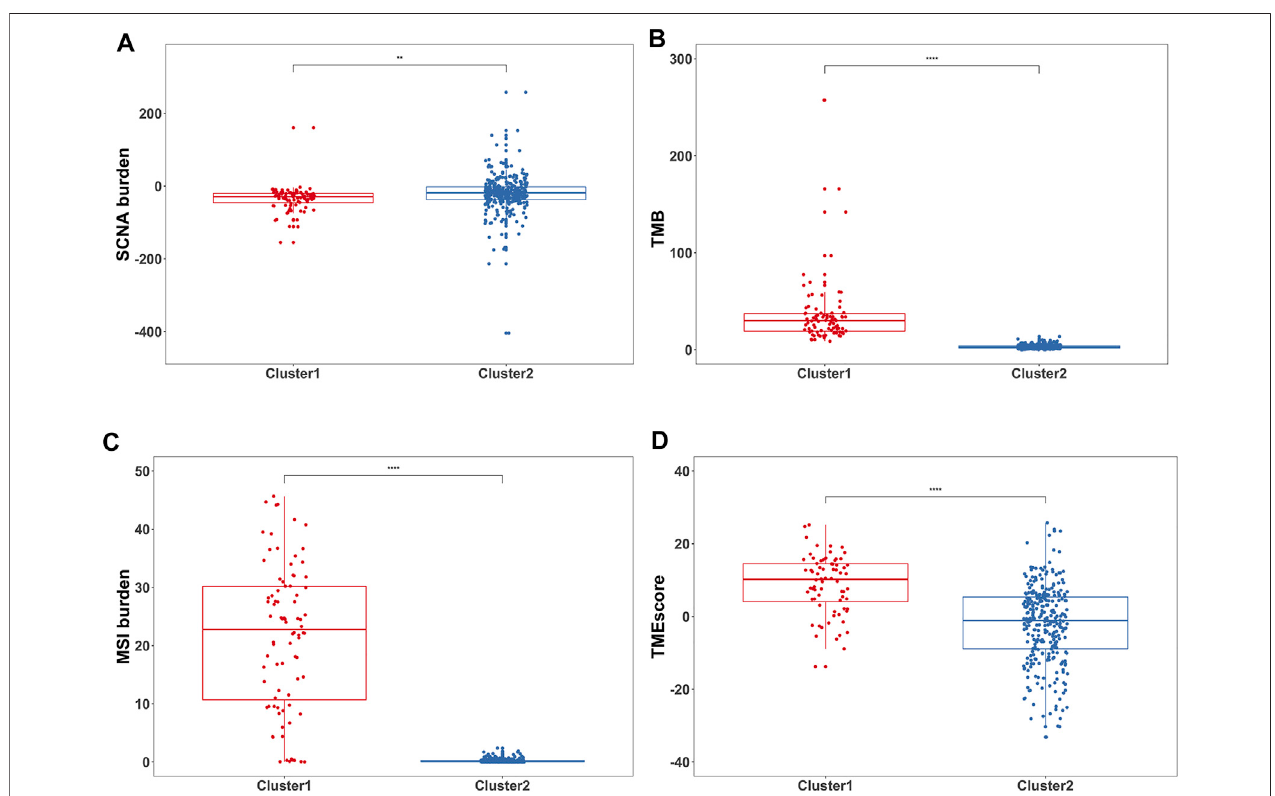
FIGURE 3 | Differences in genomic variations and immune measurement between the two subgroups. (A) Box plots showed the SCNA burden between two clusters** p < 0.01. (B) BoxplotsshowedtheTMBbetweentwoclusters**** p < 0.0001. (C) BoxplotsshowedtheMSIburden betweentwoclusters**** p < 0.0001. (D) Box plots showed the TMEscore between two clusters **** p <